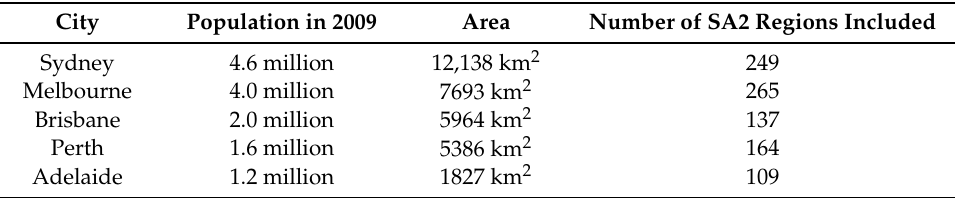
Table 1. The five Australian cities selected for this